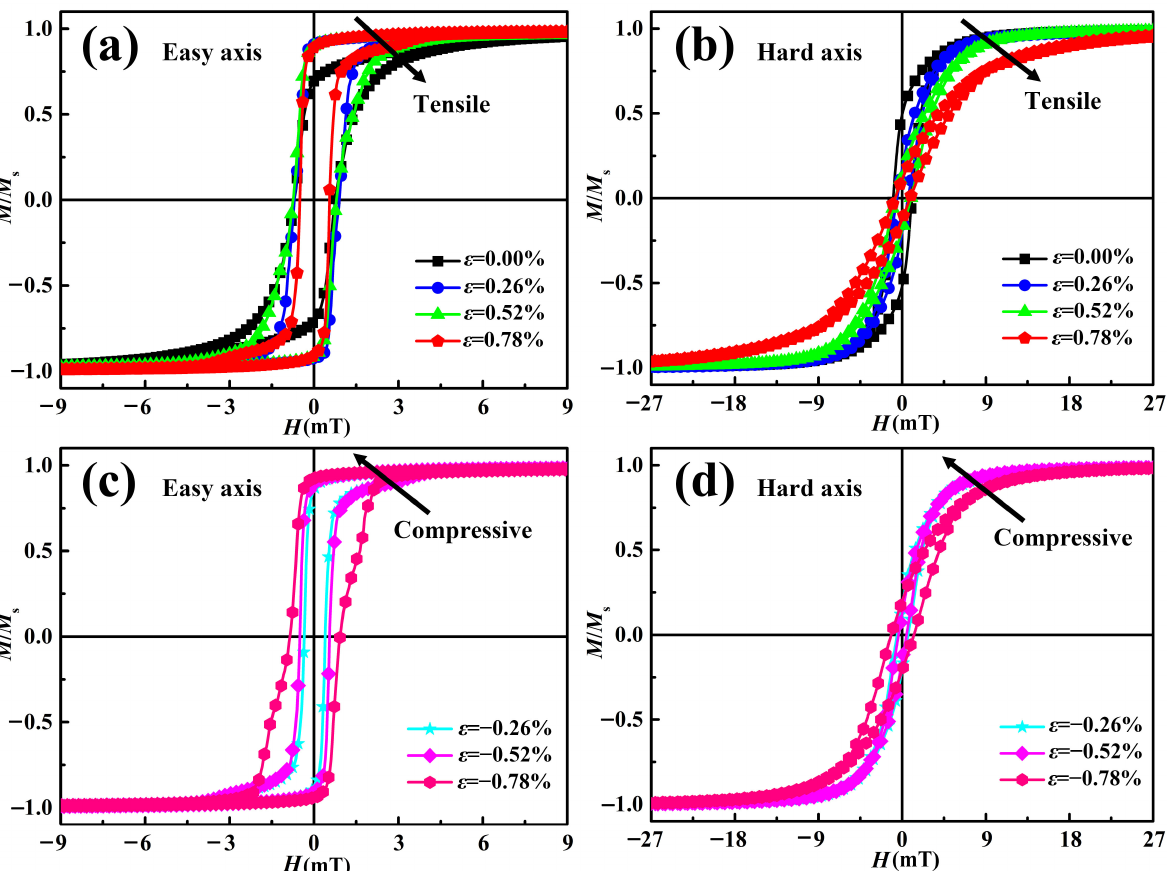
Figure 4. Magnetic hysteresis loops of TFNFT multilayer films under various external strains: ( a ) tensile strain along the easy axis (EA), ( b ) tensile strain along the hard axis (HA), ( c ) compressive strain along the EA, ( d ) compressive strain along the HA.